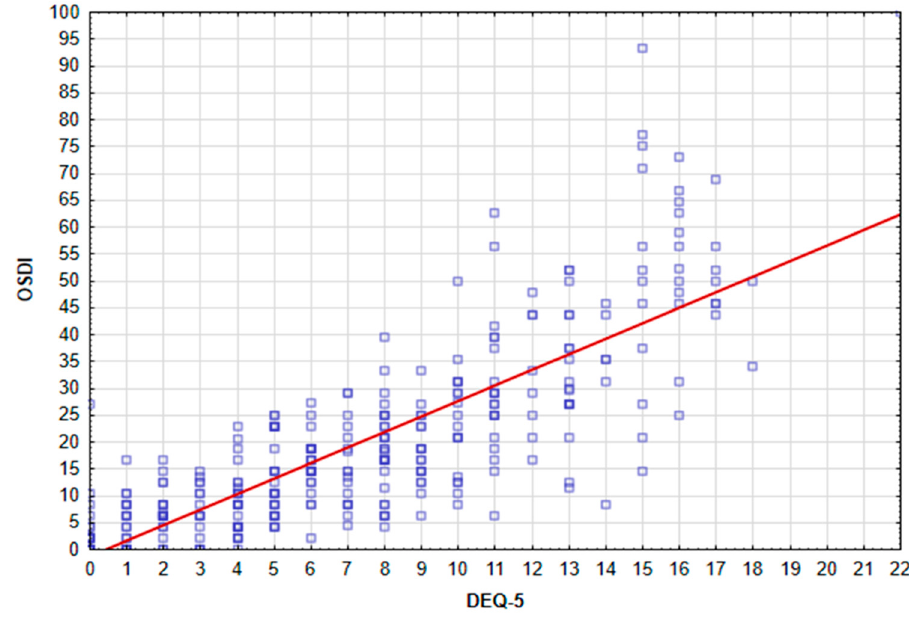
Figure 2. Scatterplot of OSDI against DEQ-5.